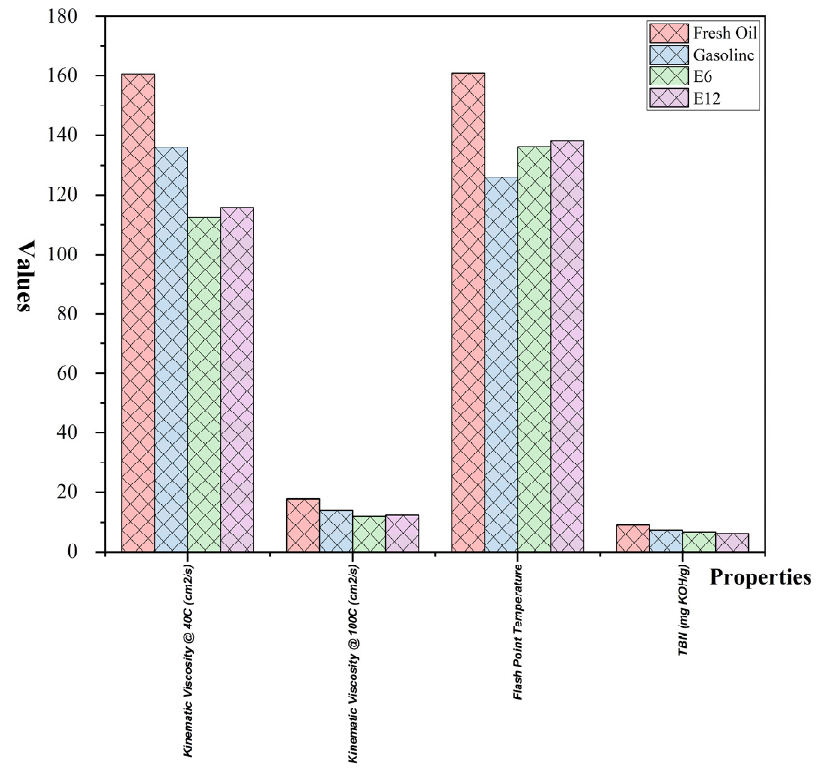
Figure 10. Comparison of lube oil properties.